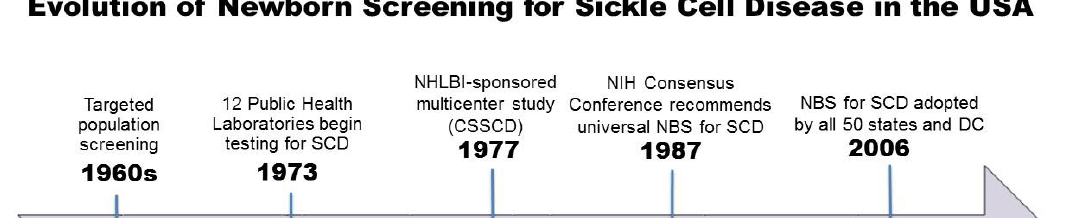
political pressure by African American advocacy groups. Only a few states performed testing for SCD in newborns and only on a selective basis.